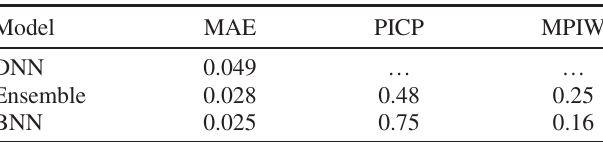
FIG. 8. Outlining the clusters of data